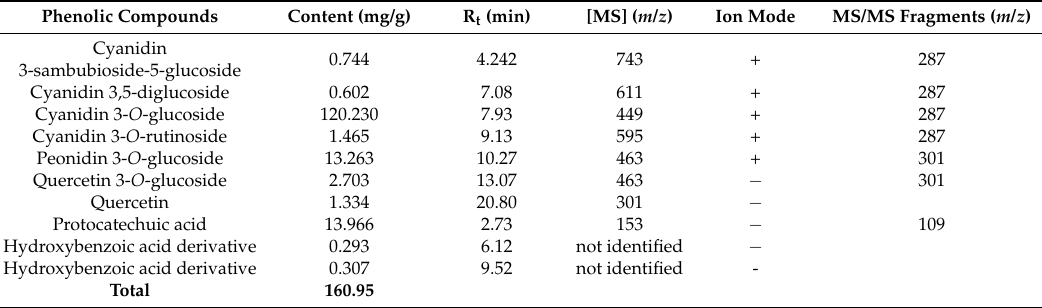
Table 1. Content (mg/g) and characterization of phenolic compounds of the elderberry extract preparation. Phenolic Compounds Content